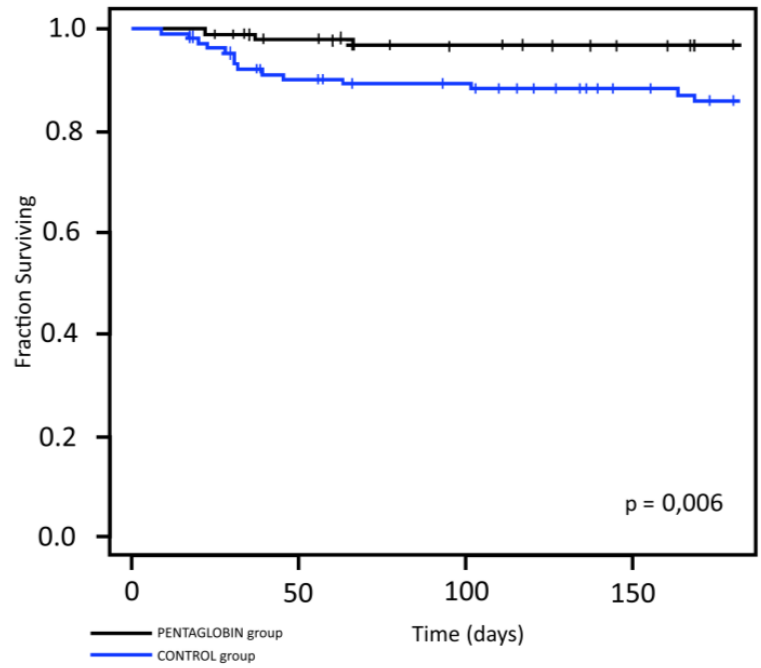
Figure 4. Kaplan–Meier survival curves in two groups calculated for deaths due to infection. Finally, a di ff erence in OS rate after six-month follow-up between the two study groups was evident when excluding mucositis and enteritis among the causes of death, even if statistical significance was not achieved ( p = 0.061) (Figure